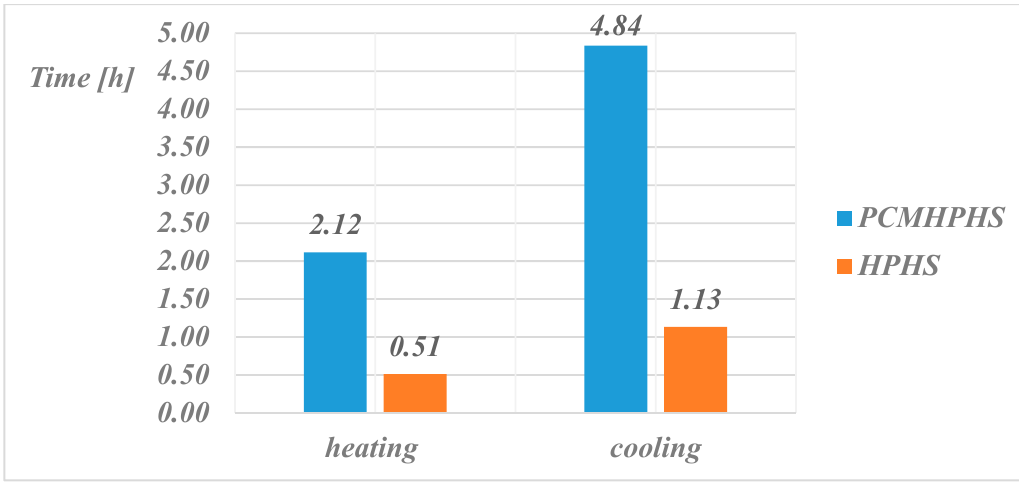
Figure 11. The results for the heating/cooling cycles.